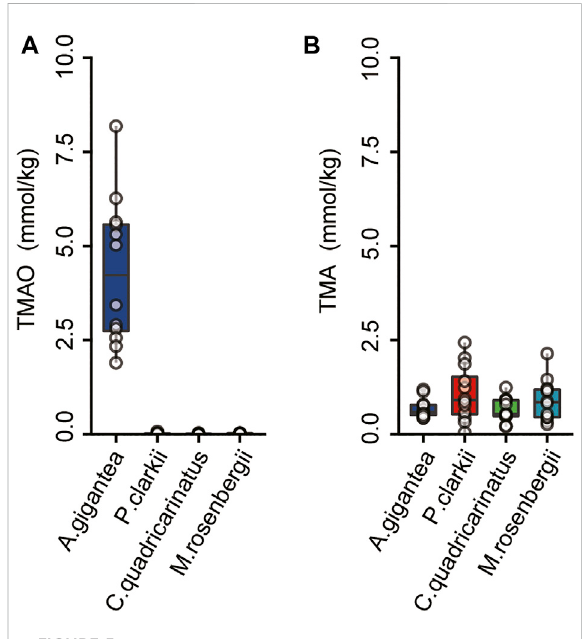
FIGURE 5 The concentrations of the TMAO and TMA in the eggs of A. gigantea. (A) and (B) , The content of the TMAO and TMA in the eggs of the A. gigantea, P. clarkii, C. quadricarinatus, and M.